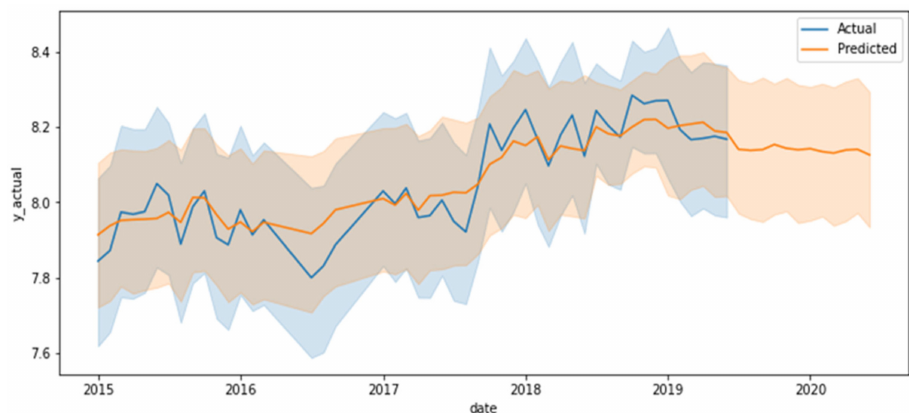
Figure 5. Random